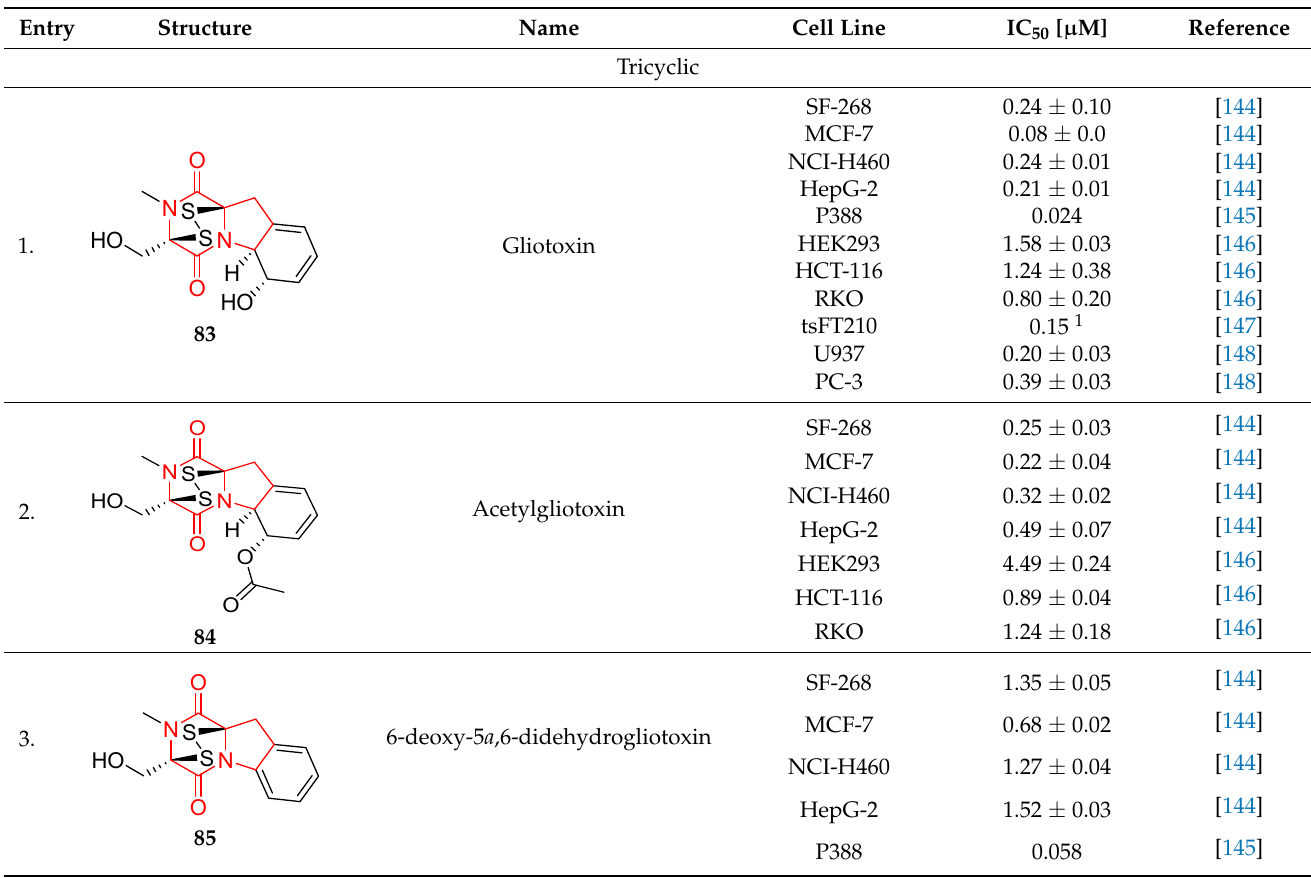
Table 6. Sulfur ‐ containing proline ‐ based DKPs.